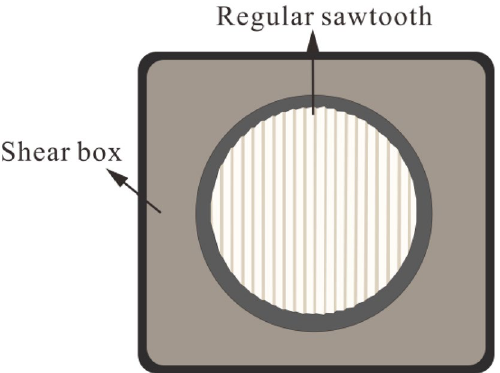
Figure 14. Plane diagram of the serrated structural plane in the test sample.